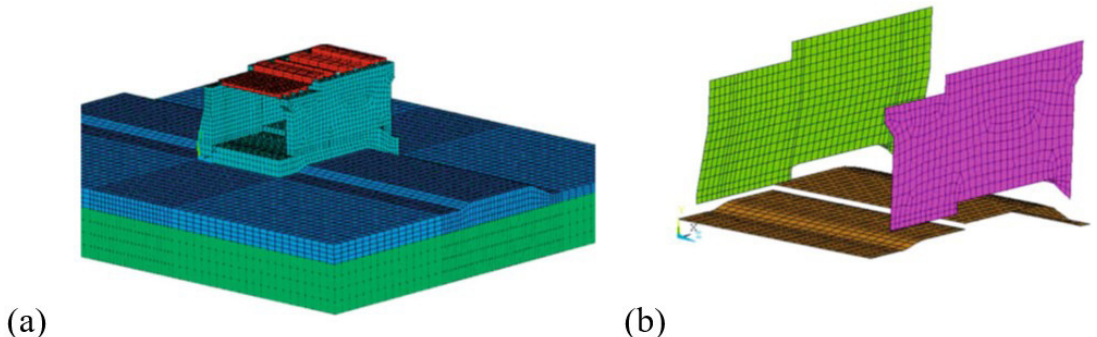
Figure 3. Finite element model for a concrete spillway: (a) with solid elements; (b) with equivalent shell elements (Dolgikh and Podvysotskii